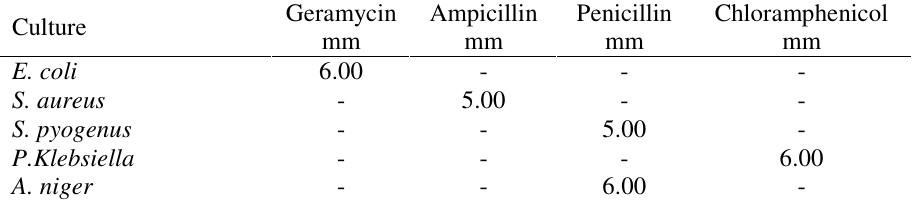
Table 3 . Zone of inhibition against standard